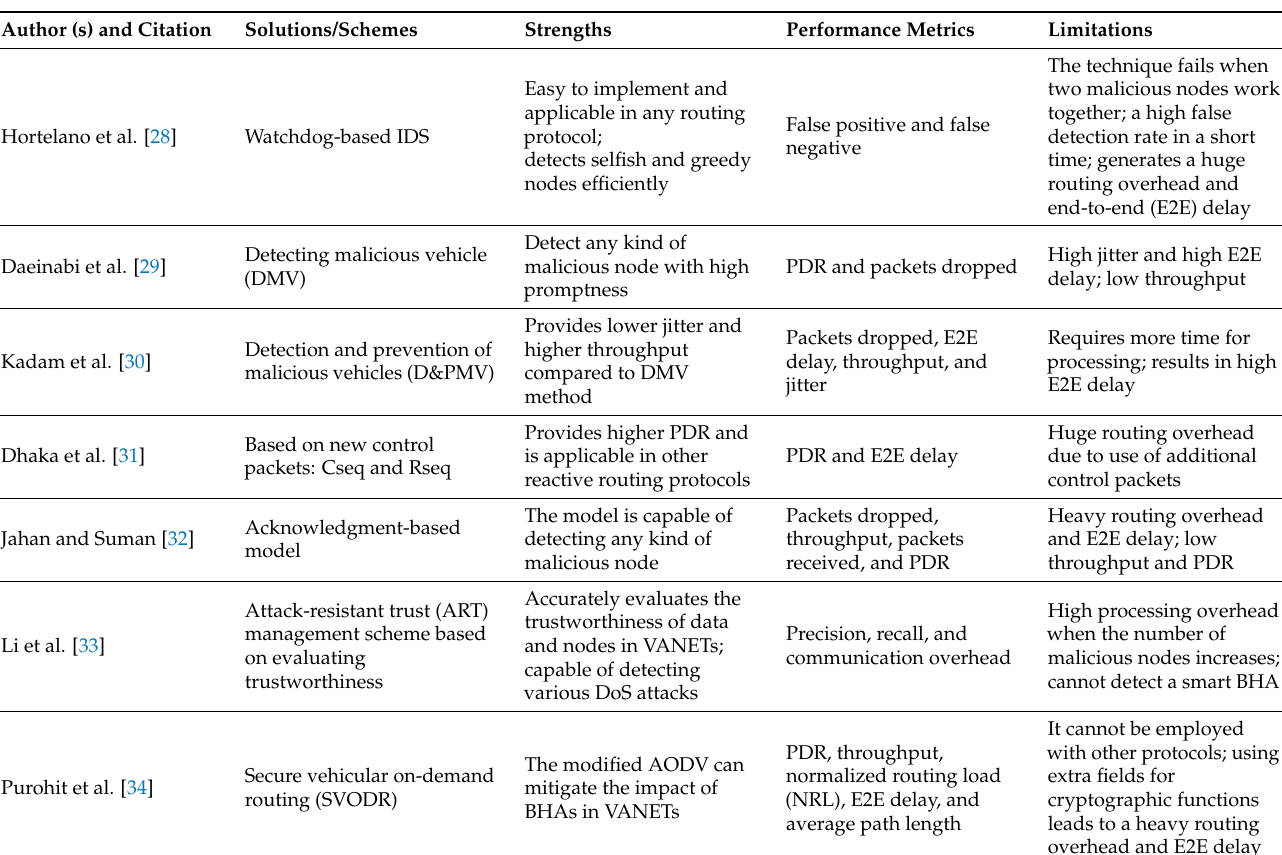
Table 1. Summarized literature